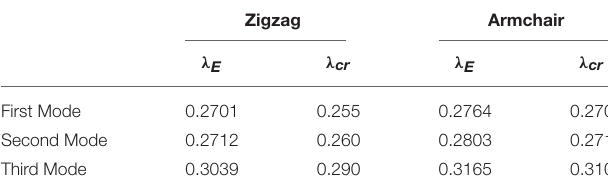
TABLE 3 | Comparison between critical multipliers.